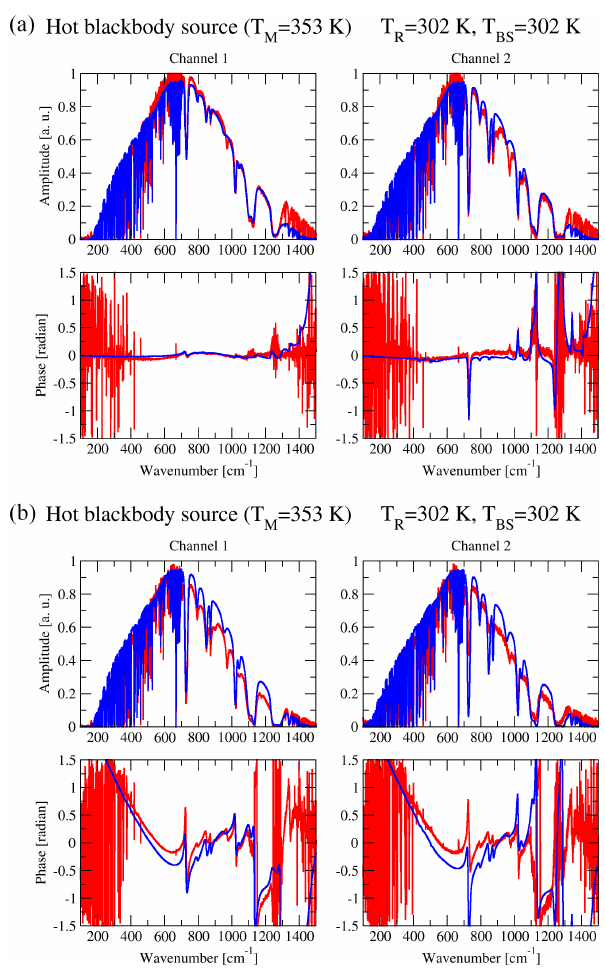
Figure 11. Simulation of the REFIR-PAD instrumental response function for different beam splitter setups (blue line). Compen- sated (a) and unbalanced (b) configurations are shown. Laboratory measurements (red line) are compared with simulation outputs for the corresponding